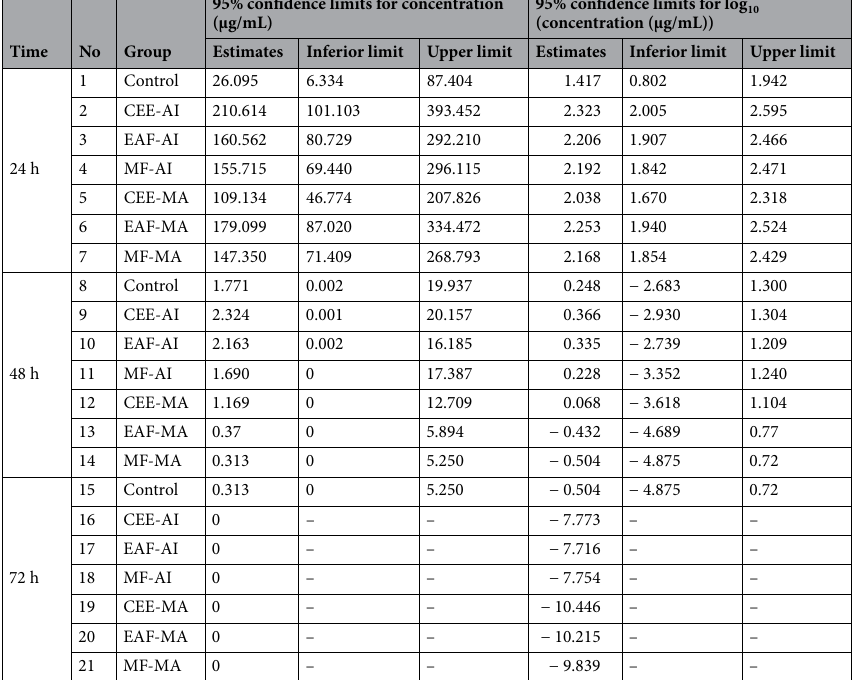
Table 1. Estimating the mean lethal concentration (LC 50 ) of crude extracts of Azadirachta indica and Melia azedarach their respective fractions of ethyl acetate and methanol in Artemia salina Leach with 95% confidence limits for concentration (µg/mL). CEE-AI: crude ethanolic extract— Azadirachta indica ; EAF-AI: ethyl acetate fraction— Azadirachta indica ; MF-AI: fraction methanol— Azadirachta indica ; CEE-MA: crude